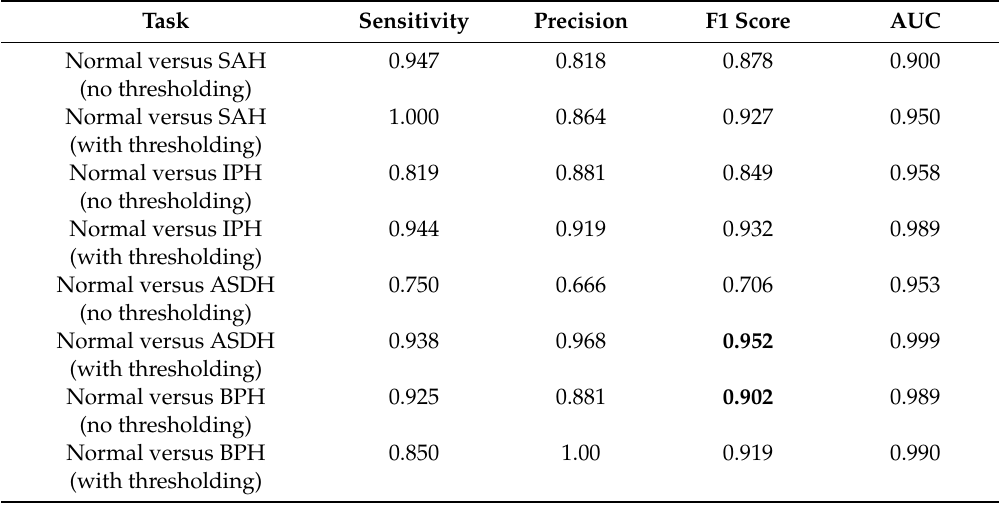
Table 4. 2-Class Classification Results (Normal versus a specific Abnormal